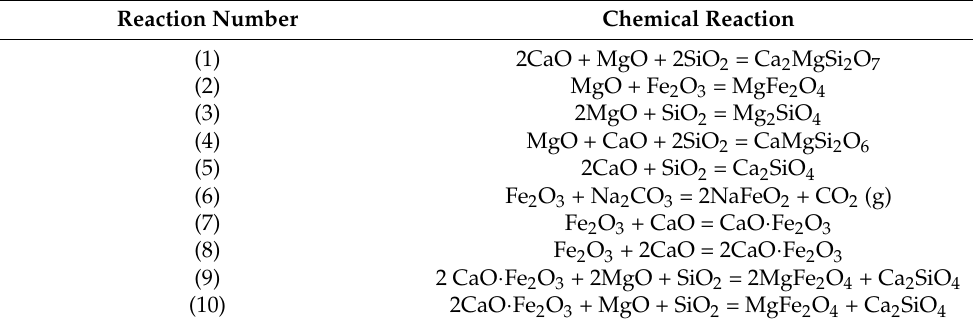
Table 3. Possible chemical reactions during the sintering process of red mud. Reaction